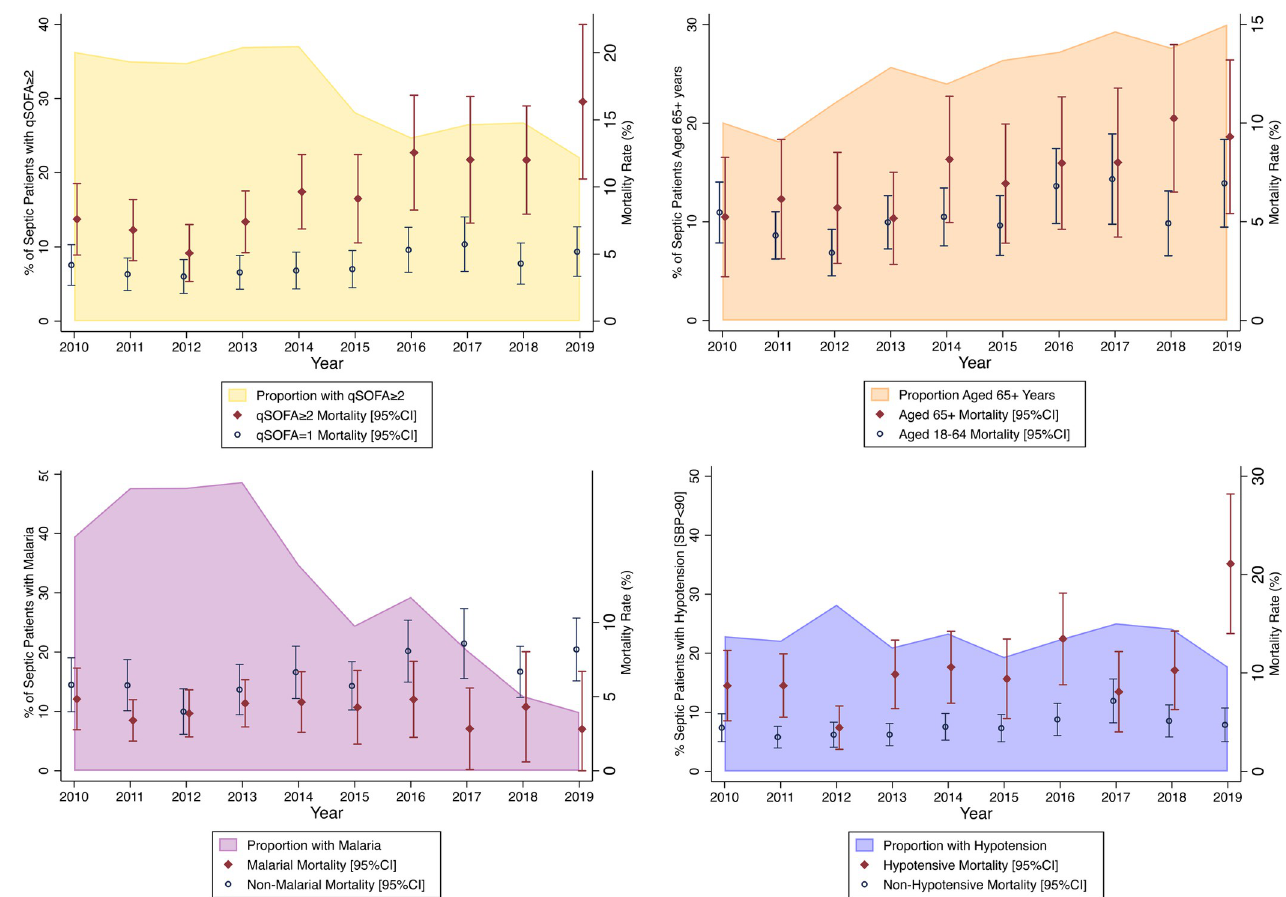
Fig 4. Proportions and comparative mortality for sub-populations of septic (qSOFA � 1) patients,